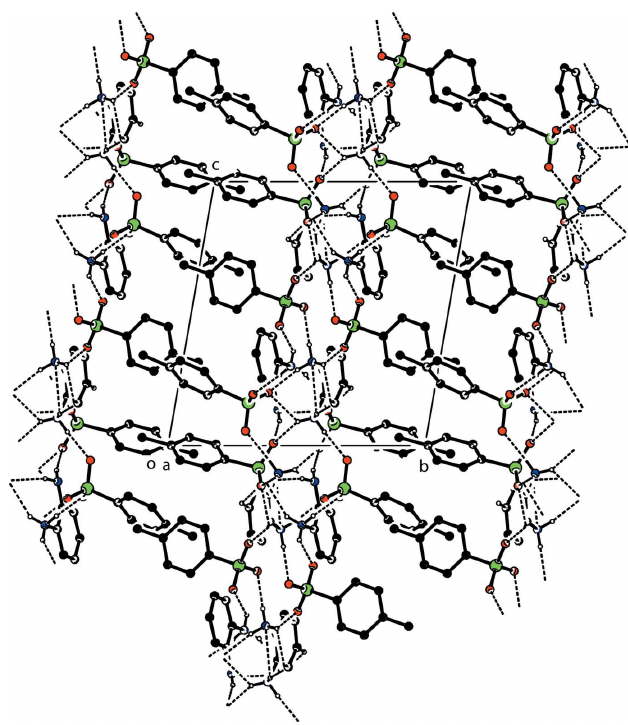
Figure 2 The crystal packing of the title molecular salt viewed along the a axis. The hydrogen bonds (Table 1) are shown as dashed lines. H atoms not involving in hydrogen bonding have been omitted for clarity.